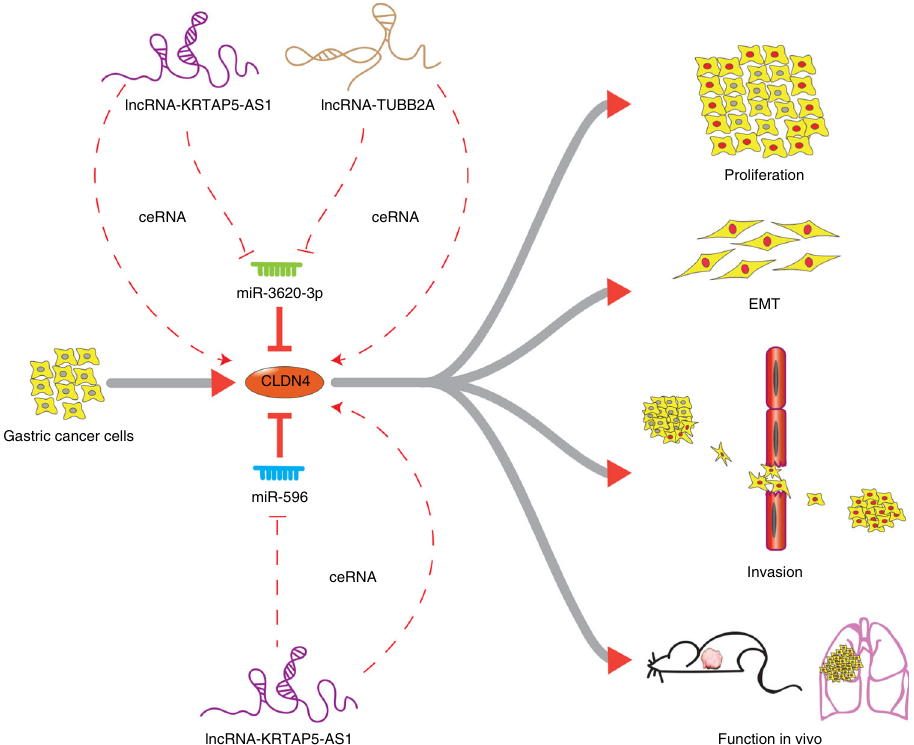
Fig. 10 The mechanism graph of the regulatory network and function of CLDN4. CLDN4 could promote proliferation, metastasis or EMT processes of GC, which could be inhibited by miR-596, miR-3620-3p and enhanced by lncRNA-KRTAP5-AS1, lncRNA-TUBB2A as